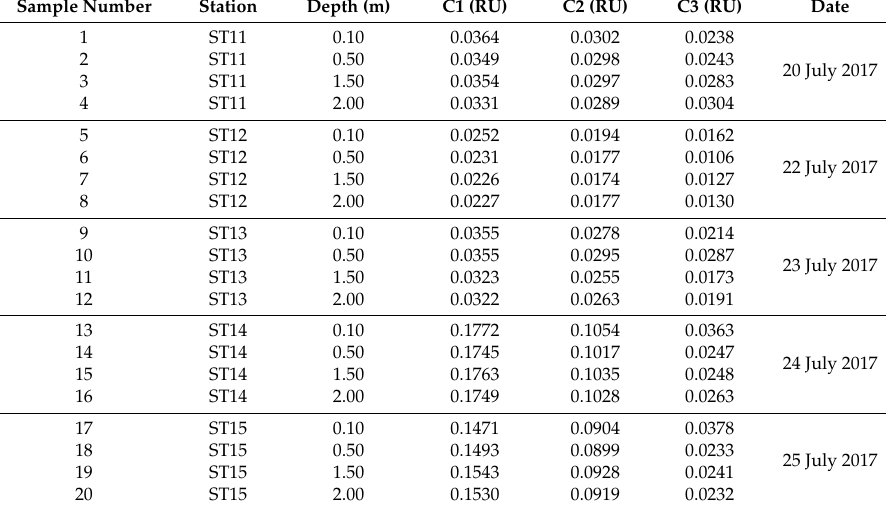
Figure 11. Top panel: PARAFAC-derived principal fluorescent components from lab-based EEM spectra from water samples at stations 11–15. From left to right: (C1) Terrestrial humic-like peaks A C and C; (C2) marine humic-like peaks A M and M; and (C3) protein-like Tryptophan peak T, all peaks denoted after Coble [29]. Color bar shows Raman units (RU). Bottom panel: PARAFAC derived principal fluorescent components from Kallemeter-based EEM spectra along the transect. Table 2. Spectroscopic composition of the lab-based LS55 spectrofluorometer EEM spectra analyzed water samples in Trondheimsfjord. C1, C2, and C3 represent the intensity of PARAFAC components in Raman units. Sample Number Station Depth (m) C1 (RU) C2 (RU) C3 (RU)